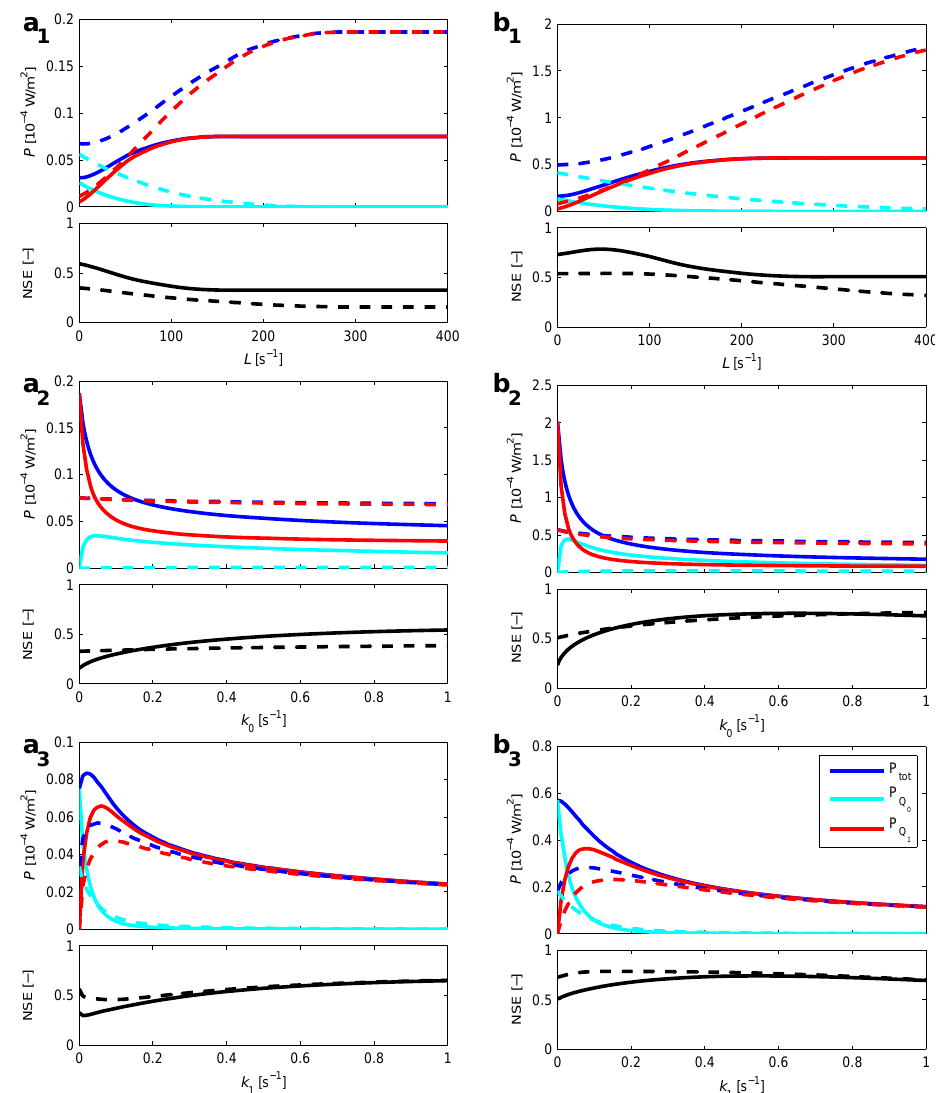
Fig. 4. Sensitivity of (1) L , (2) k 0 and (3) k 1 to power of the different fluxes leaving the fast runoff reservoir and associated mass balance error for the HJ Andrews watershed 2. The input flux ( Q d ) for simulations in panels a 1 –a 3 are derived from the point of maximum power in G of the solid line in Fig. 2a, while the input flux for simulations in panels b 1 –b 3 are derived from the point of maximum power in Q d of the dashed line in Fig. 2a. Total power is plotted in blue, power by Q 0 in light cyan and power by Q 0 in red. The dotted and dashed lines represent two different parameter sets (see Table